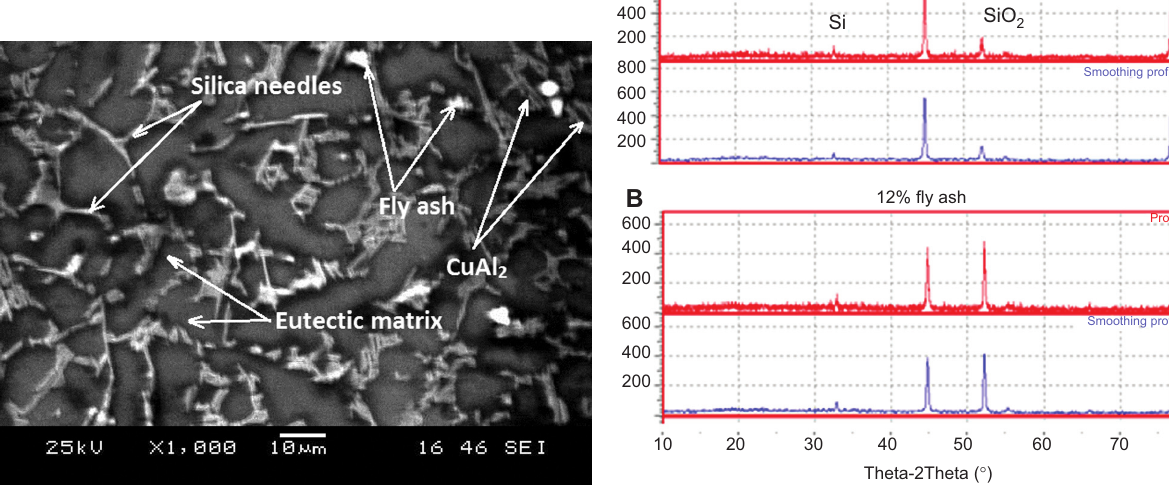
Figure 2 XRD pattern of the composite material (75–103- μ m particle